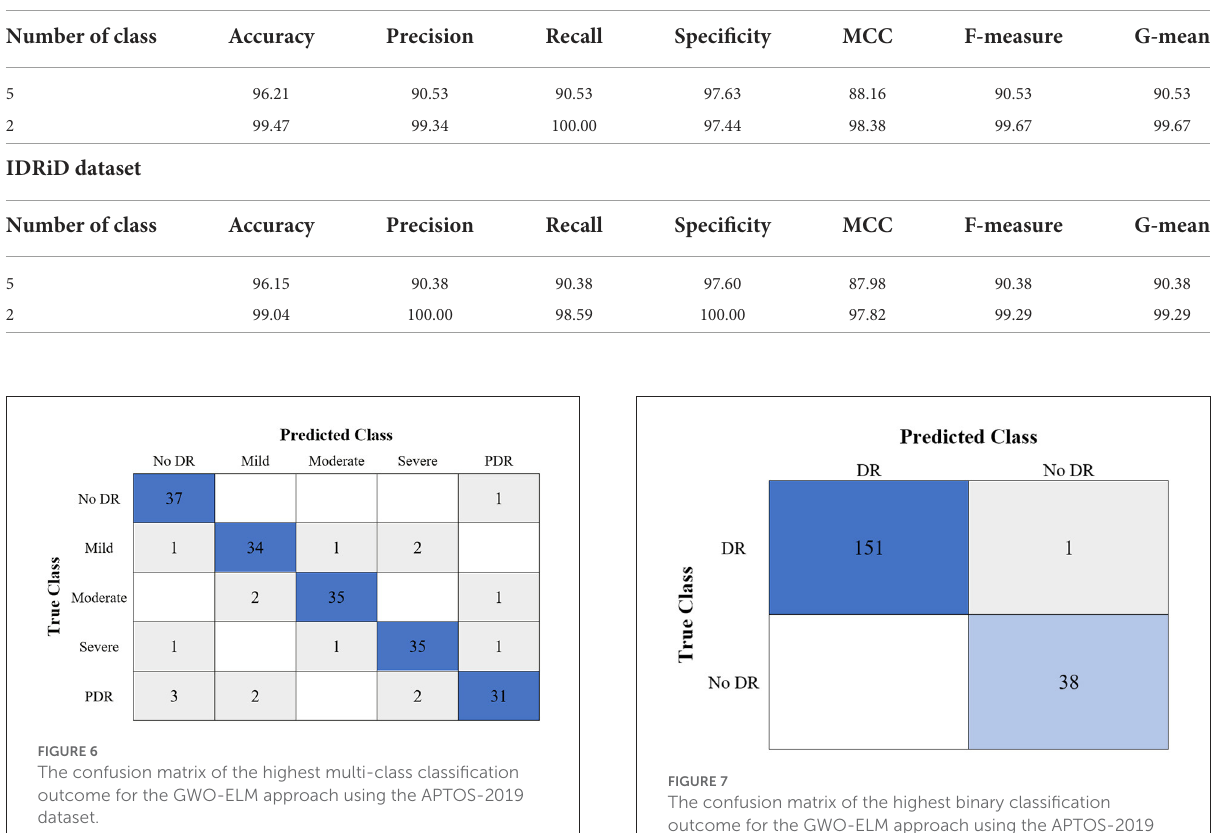
TABLE 6 The highest experiment outcomes of the binary and multi-class classifications for GWO-ELM approach using APTOS-2019 and IDRiD datasets.